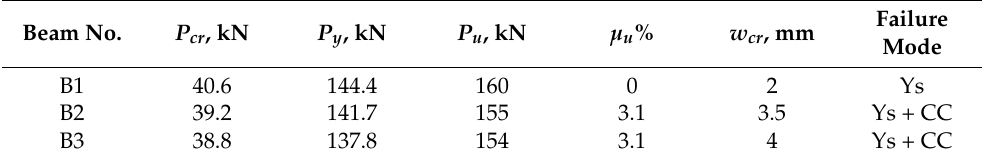
Table 3. Experimental results of the tested RC beams. Beam